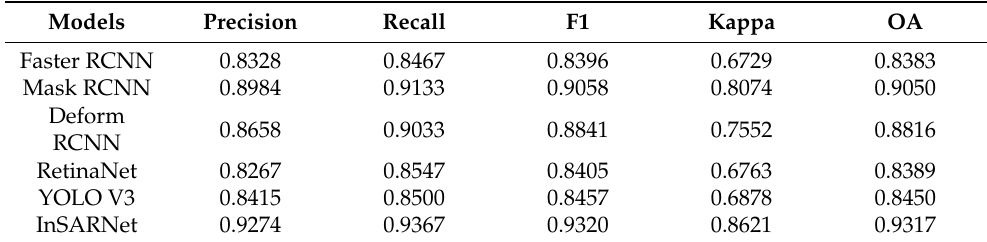
Table 8. Comparison of the accuracies of the different detection models in test area A.